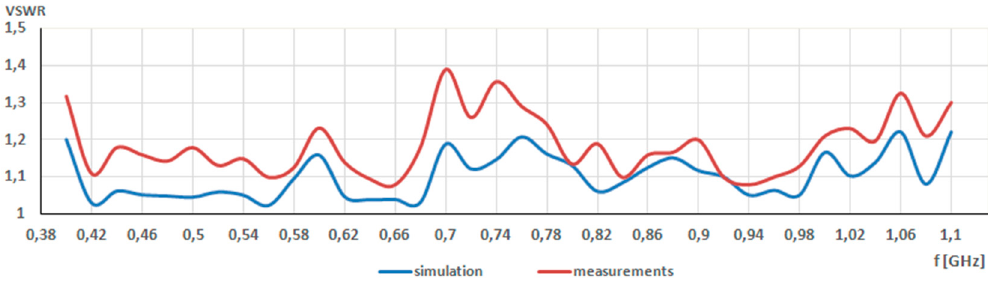
Figure 9. Simulated and measured VSWR for frequency range from 400 MHz to 1100 MHz.